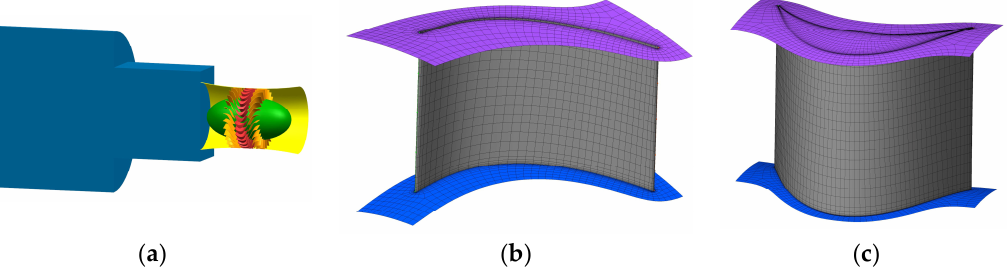
Figure 3. ( a ) Detail of the flow passage with guide vanes and rotating blades. ( b ) Detail of the guide vane. ( c ) Detail of the blade.